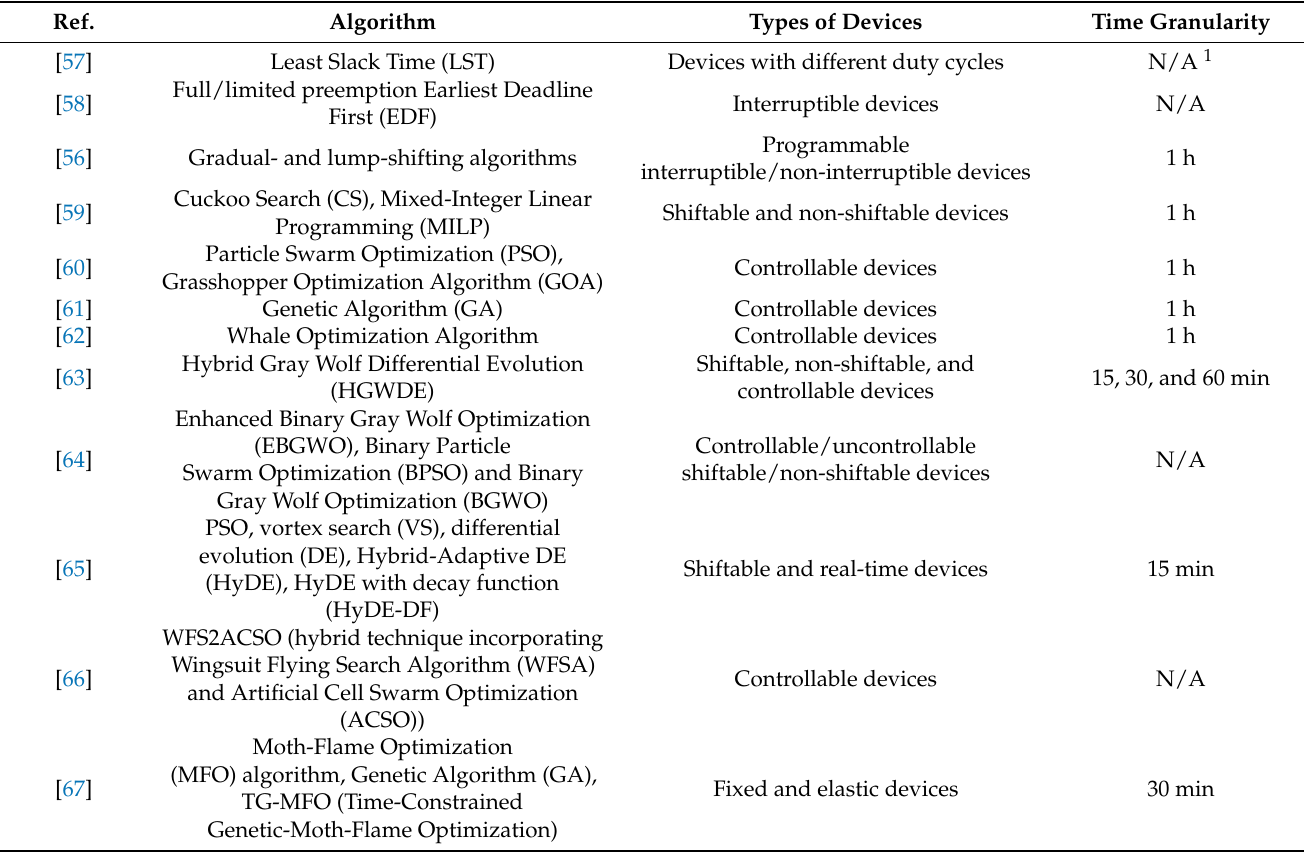
Table 4. Load scheduling algorithms for